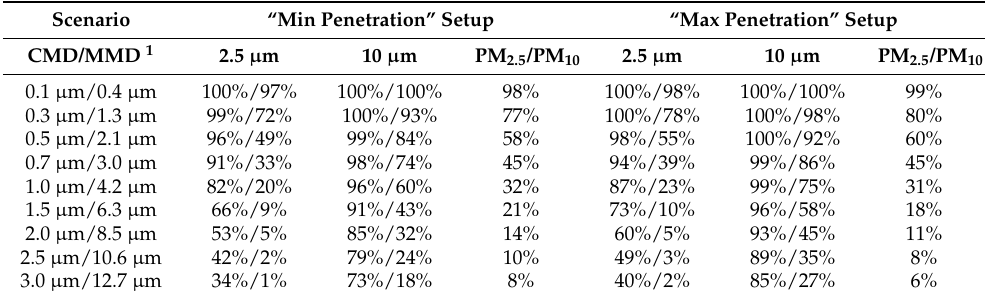
Table 2. Calculated number/mass (polydisperse) penetrations of two PM setups (with “min penetra- tion” and “max penetration”) using 2.5 µ m and 10 µ m cyclonic separators for various count median diameters (CMDs) or mass median diameters (MMDs). The PM 2.5 to PM 10 mass ratio is also given. See Table 1 for details on the different